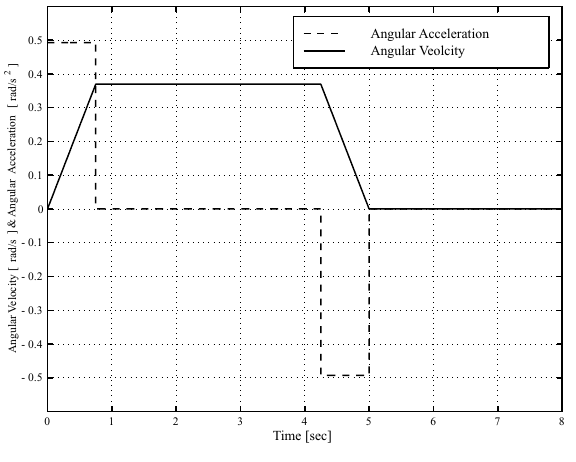
Fig. 20. Operator rotational